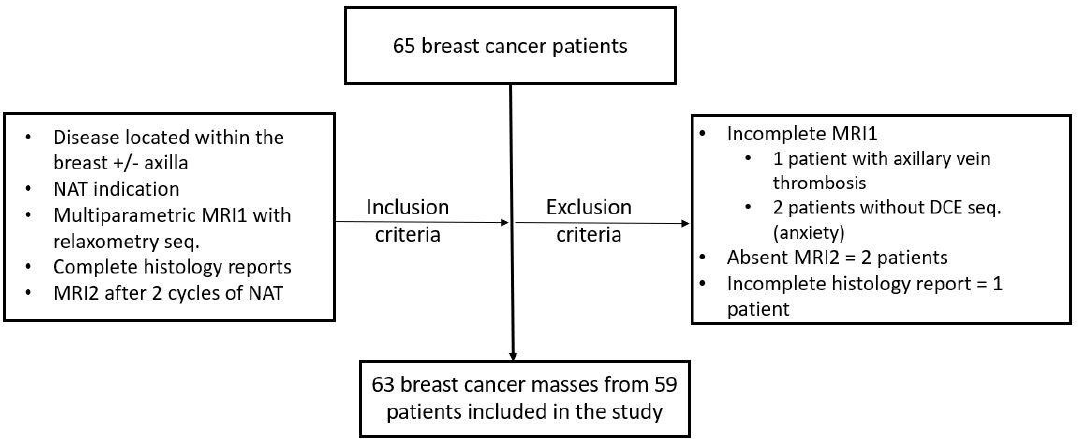
Figure 3. Study population ‐ inclusion and exclusion criteria.